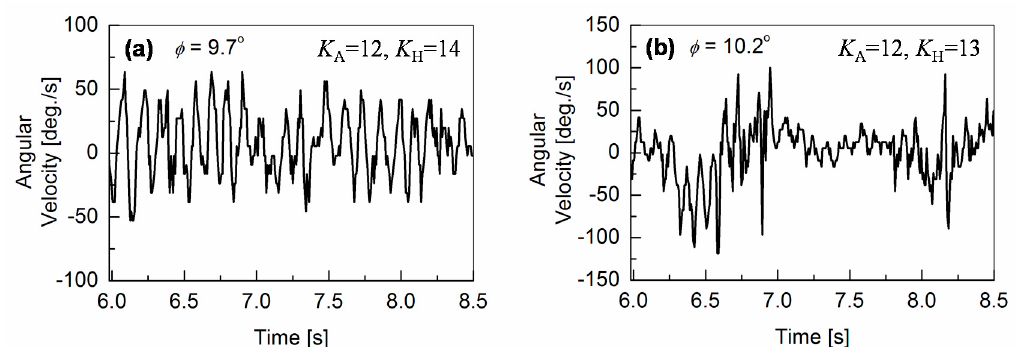
Figure 7. Angular-pitch velocity for a gait cycle with both ankle-pitch-motor control and hip-pitch-motor control, measured at different higher surface inclinations. ( a ) Robot vibrations increase for K H = 14 in the hip-pitch-motor control. ( b ) K A = 12 and K H = 13 are an optimized motor-control setting, allowing stable down-slope walking up to inclinations of φ = 10.2°.